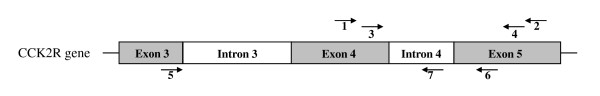
Schematic drawing (not to scale) of the CCK2R gene 3'-region corresponding DNA sequences of exon 3 to exon 5. Arrows indicate the position of the CCK2R primers No. 1-7 described in Table 1.